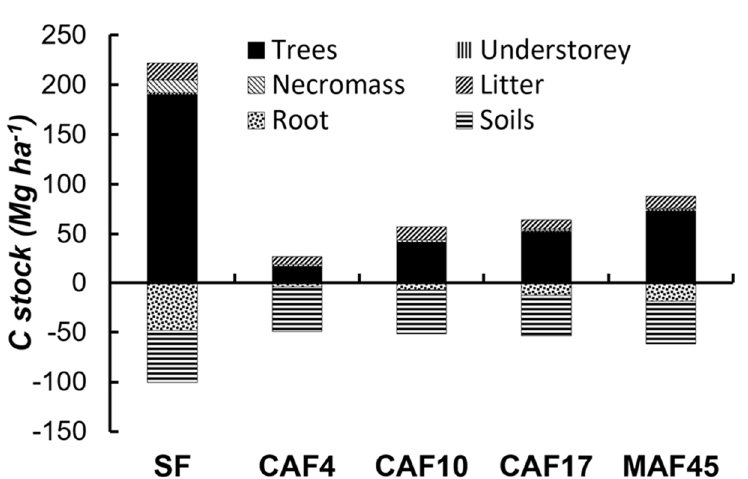
Figure 6. Total above– and below–ground carbon stock of remnant secondary forest (SF) compared with cocoa agroforestry that is 4–5 years old (CAF4), cocoa agroforestry that is 10–12 years